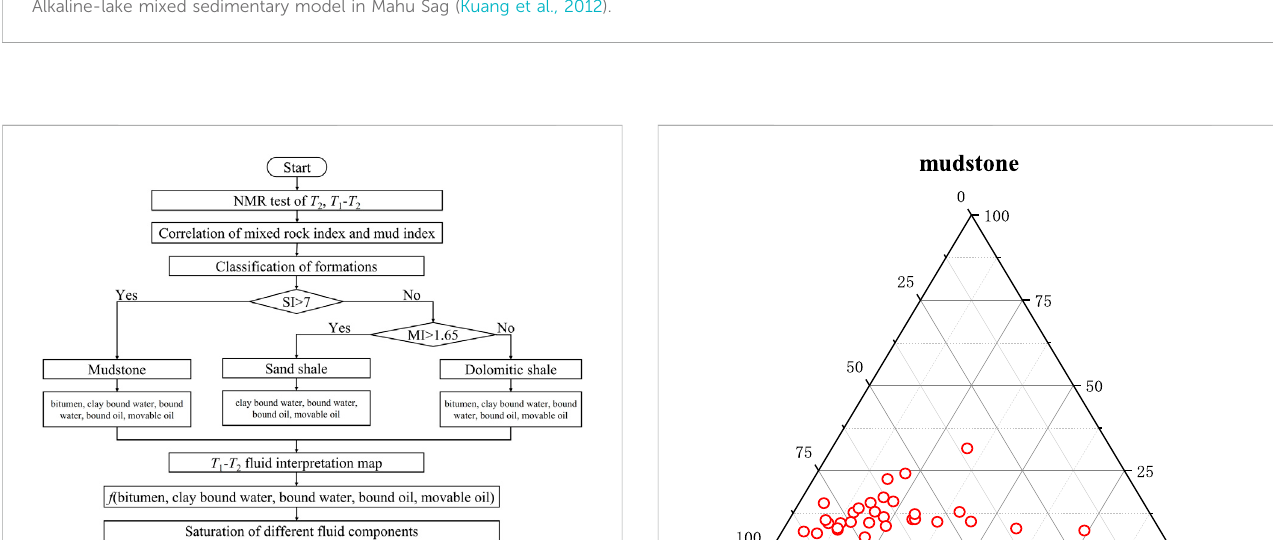
Alkaline-lake mixed sedimentary model in Mahu Sag (Kuang et al., 2012).